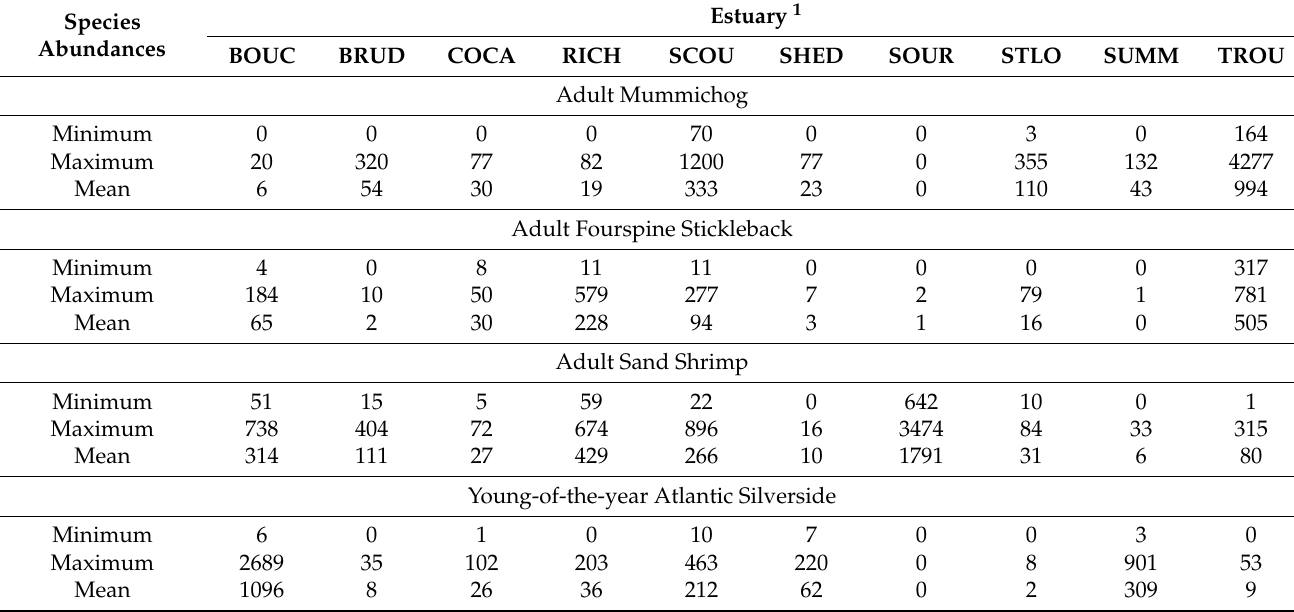
Table 7. Minimum, maximum, and mean counts of the four influential species for each estuary.